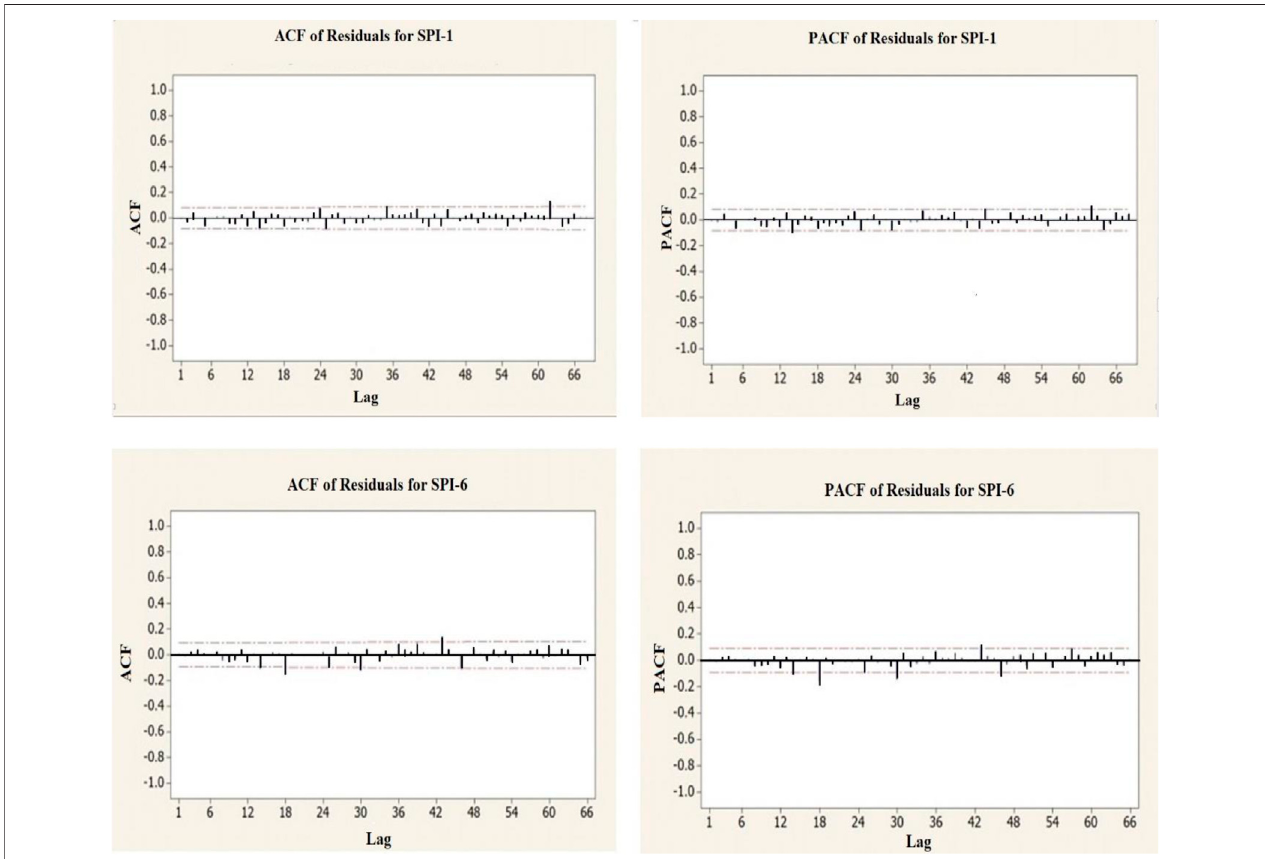
FIGURE 8 | ACF and PACF diagrams of residual of the selected model for one- and six-month drought index time series.